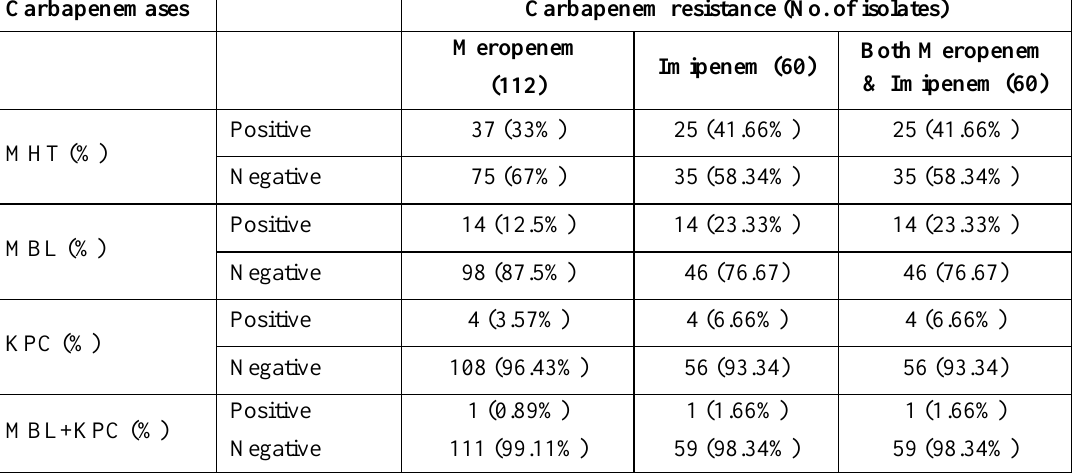
Table 2. Distributions of carbapenemases.